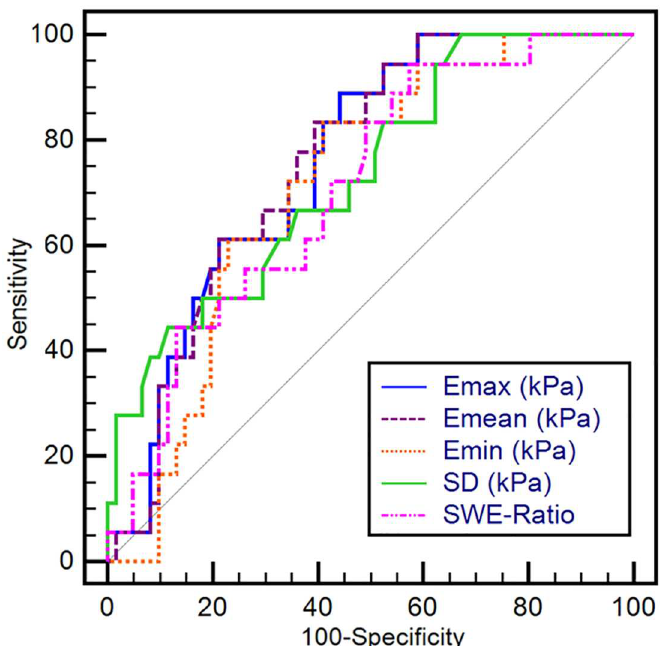
Fig 2. The receiver-operating characteristic curves (ROC) curves of shear-wave elastography for differentiating benign and atypical or malignant papillary lesions. The ROC curves for quantitative (Emax, Emean, Emin, SD, and SWE-Ratio) shear-wave elastographyfeatures were significantly different betweenbenignand atypical or malignant papillarylesions(area under the curve, 0.707–0.757; sensitivity, 44.4–94.4%; specificity,